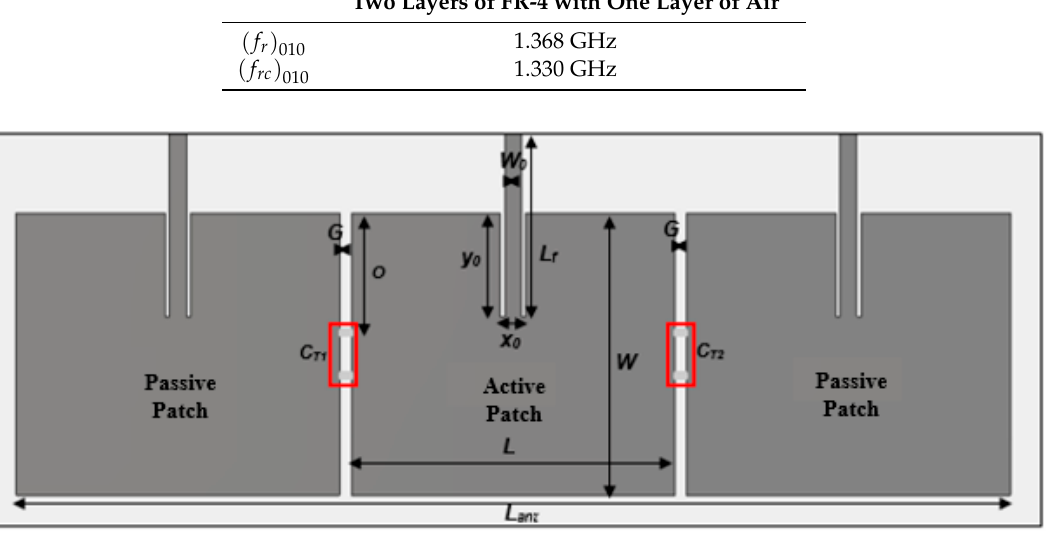
Figure 4. Structure and dimensions of the P-ESPAR antenna in the frontal perspective [15].